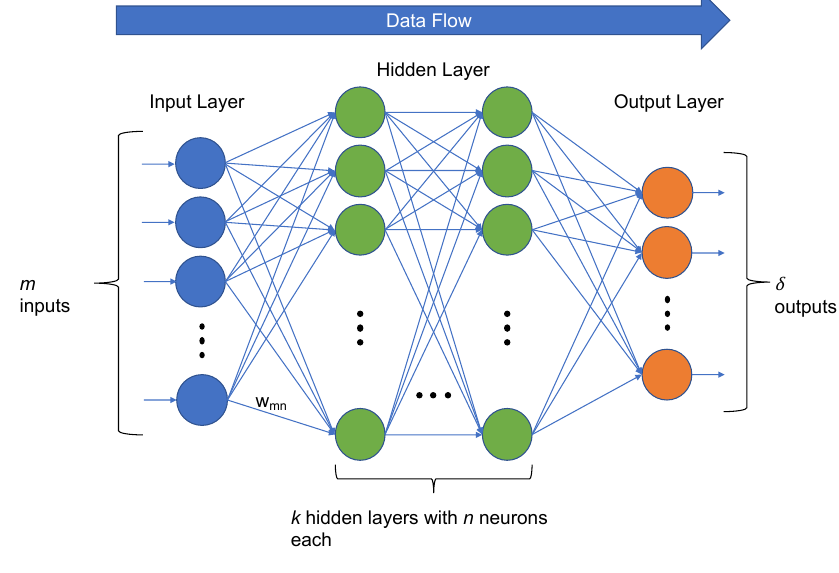
Figure 12. Artificial neural network.